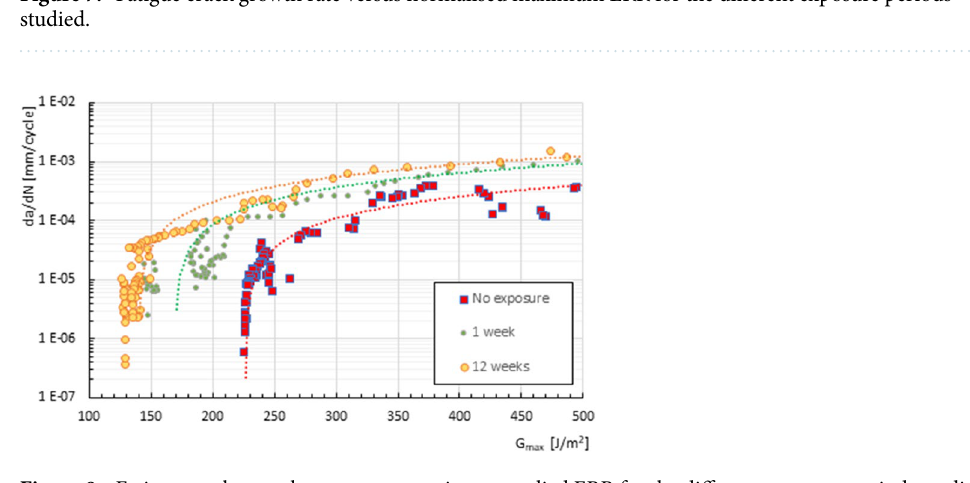
Figure 8. Fatigue crack growth rate versus maximum applied ERR for the different exposure periods